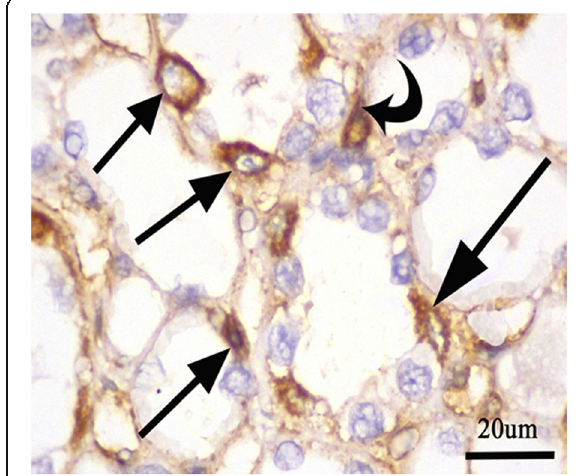
Fig. 1 Immunohistochemical stained section of renal tubules of ADMSC for CD44 at magnification × 1000; bar 20 μ m shows intense positive reaction in the cytoplasm of spindle shaped MSC which is incorporated with (arrow) or in between (curved arrow) cells of the renal tubules